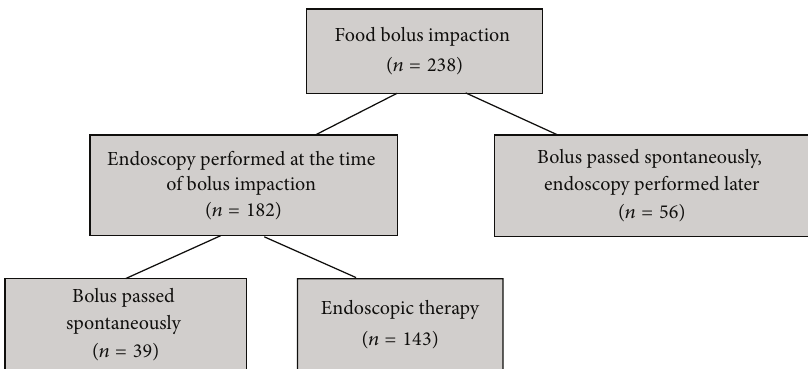
Figure 1: Flowchart showing the endoscopy